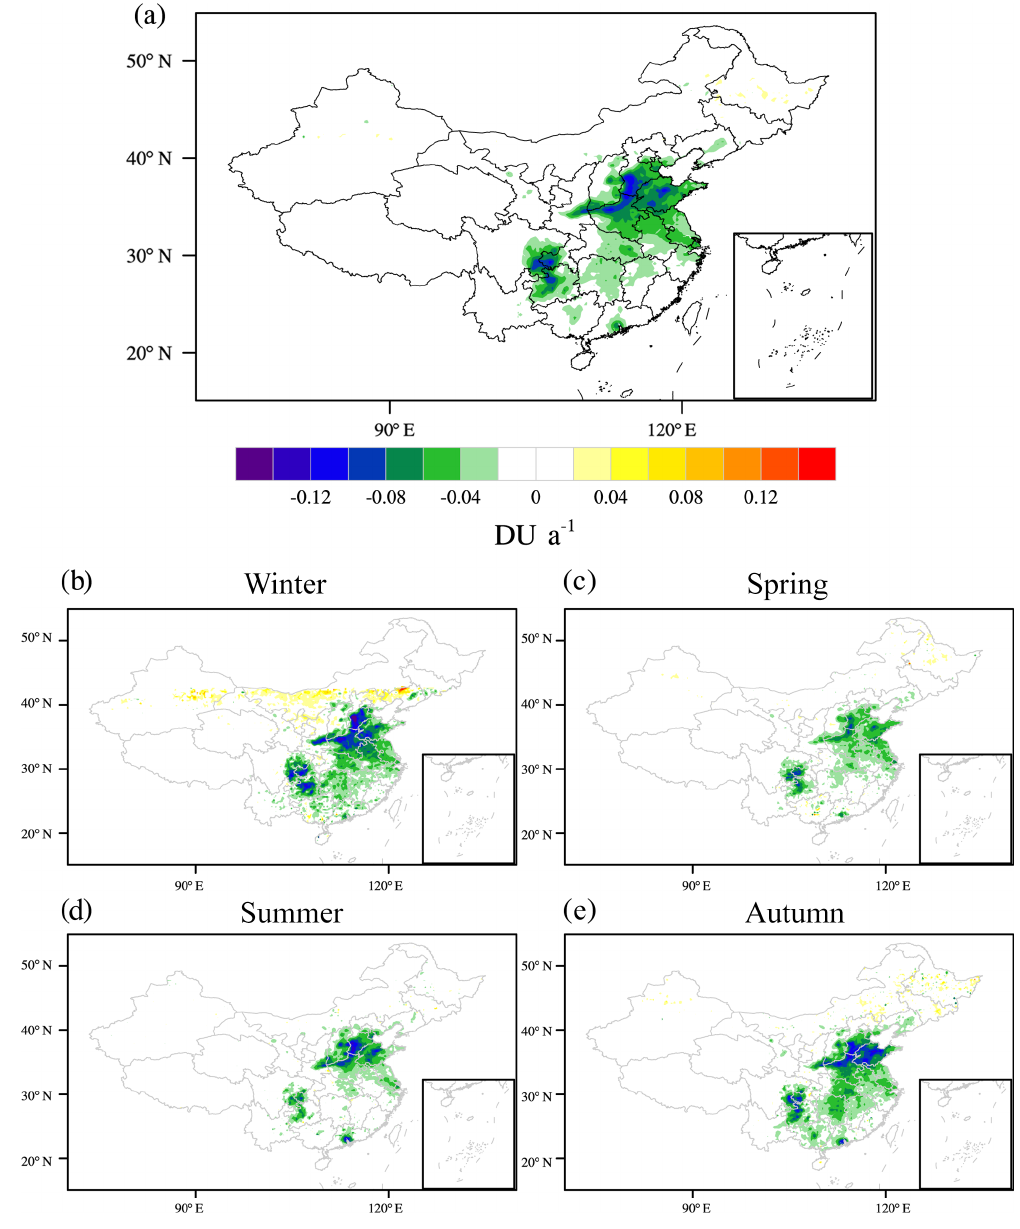
Figure 5. Spatial pattern of SO 2 linear trends (2005–2016) in annual (a) and seasonal (b–e)